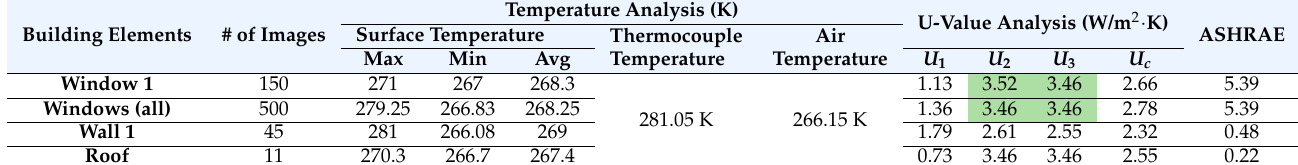
Table 10. Twamley U-value estimation (morning), 17 March